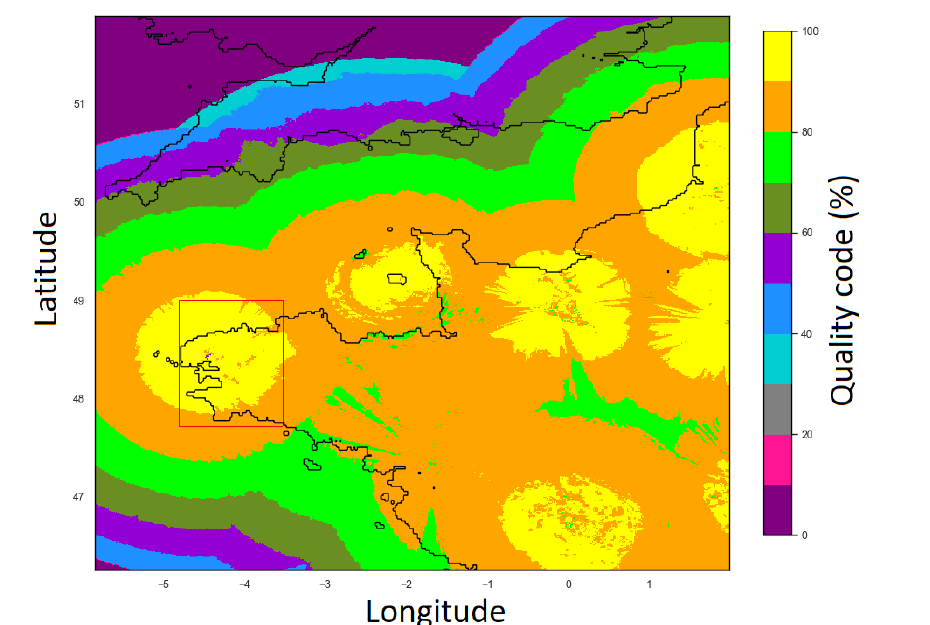
Figure 3. Mean over three years (2016 to 2018) of the quality code, a score quantifying the acquisition of the rainfall data, in the northwest of France with the study area framed in red. Missing data were set to